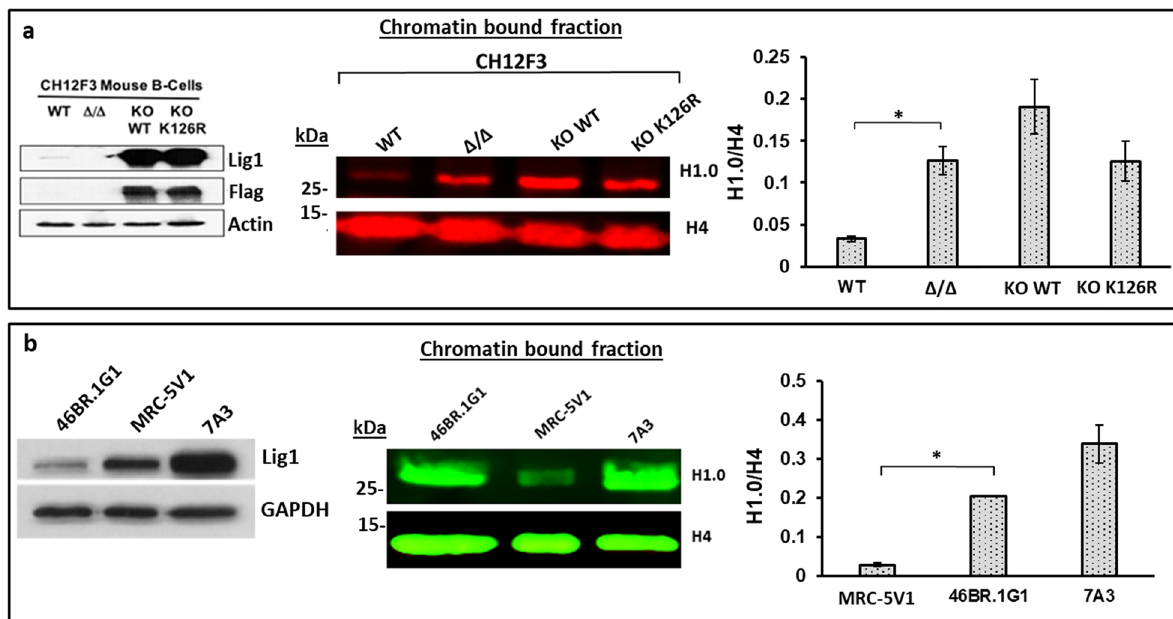
Figure 7. Increased levels of chromatin bound H1.0 in Ligase I deficient cells. ( a) Immunoblots of whole cell extracts (50 μg, left panel) and chromatin fractions (50 μg, middle panel) from CH12F3 wild type cells (WT) and a LIG1 null derivative (Δ/Δ) as well as the LIG1 null cells expressing either Flag-tagged wild type LigI (KO WT) or the TARK mutant version (KO K126R) with the indicated antibodies. ( b) Immunoblots of whole cell extracts (50 μg, left panel) and chromatin fractions (50 μg, middle panel) from LigI-deficient 46BR.1G1 cells (46BR.1G1), a complemented derivative of 46BR.1G1 cells stably expressing wild type LigI (7A3) and a comparable wild type human fibroblast (MRC-5V1). Data shown graphically are the mean ( ±) SEM of three independent experiments. Unpaired two-tailed Student test. ‘*’ P-values < 0.05. Uncropped Western blots are shown in supplementary Fig